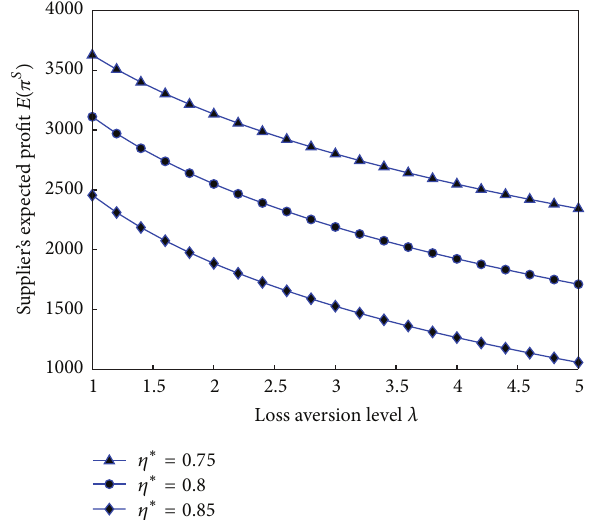
Figure6:Plotofthesupplier’sexpectedprofitwith 𝜆 underdifferent values of 𝜂 ∗